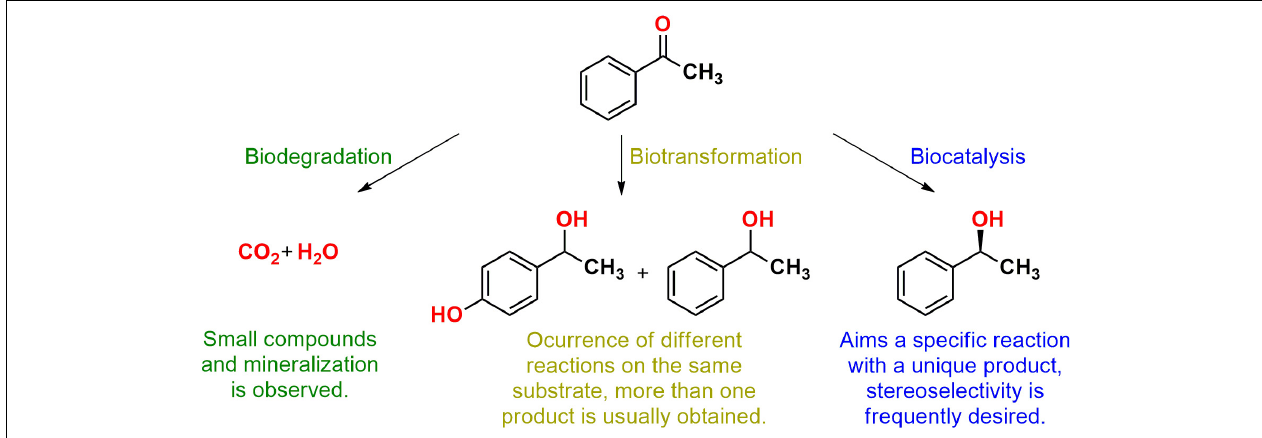
FIGURE 1 | Illustration of a biodegradation, a biotransformation, and a biocatalytic reaction according to the definitions employed in this